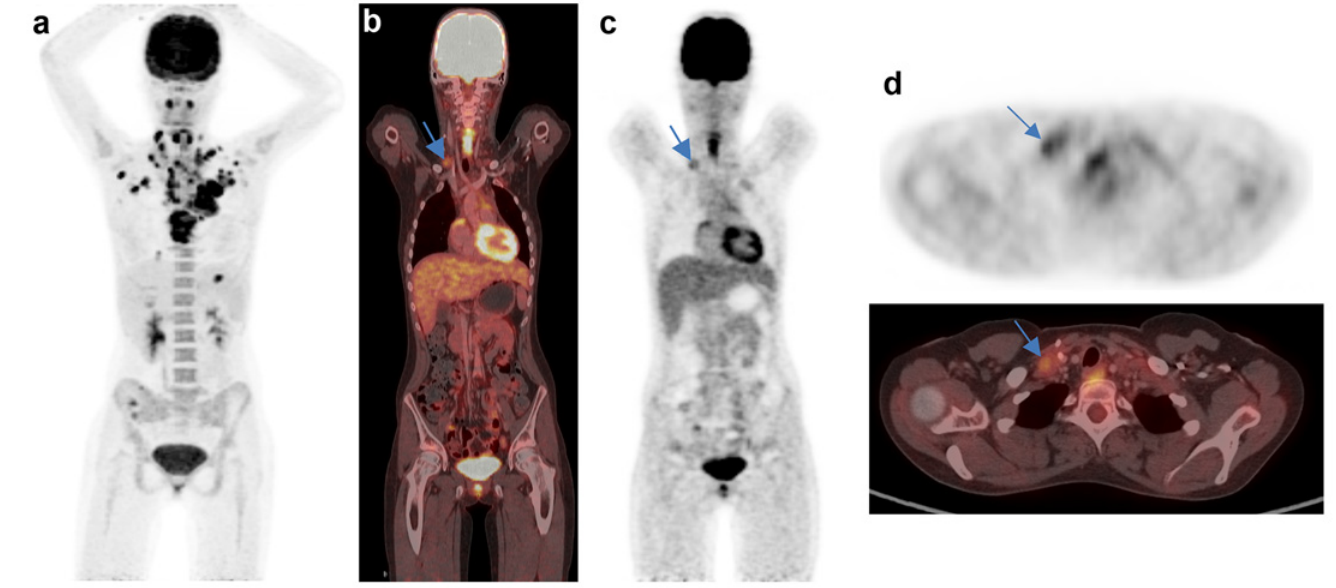
Fig 5. Discrepant D scoring of the right supraclavicular region. Case 2.: a) extensive lymphoma involvement including the right supraclavicular region before treatment. b — d) enhanced FDG uptake in a right supraclavicular node clearly exceeding that of the mediastinum. It is difficult to decide if the nodal uptake is higher or less than the liver uptake. Deauville score of the readers R1-5 for the supraclavicular region, respectively: 3-4-3-3-4. Courtesy Dept. Nuclear Medicine, University Hospital Erlangen, Germany.